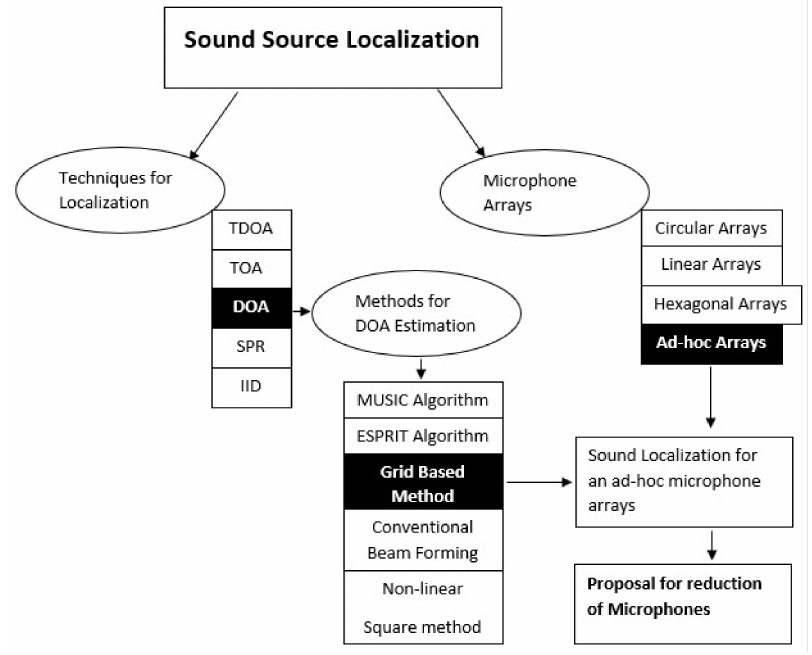
Figure 1. Overview of the proposed